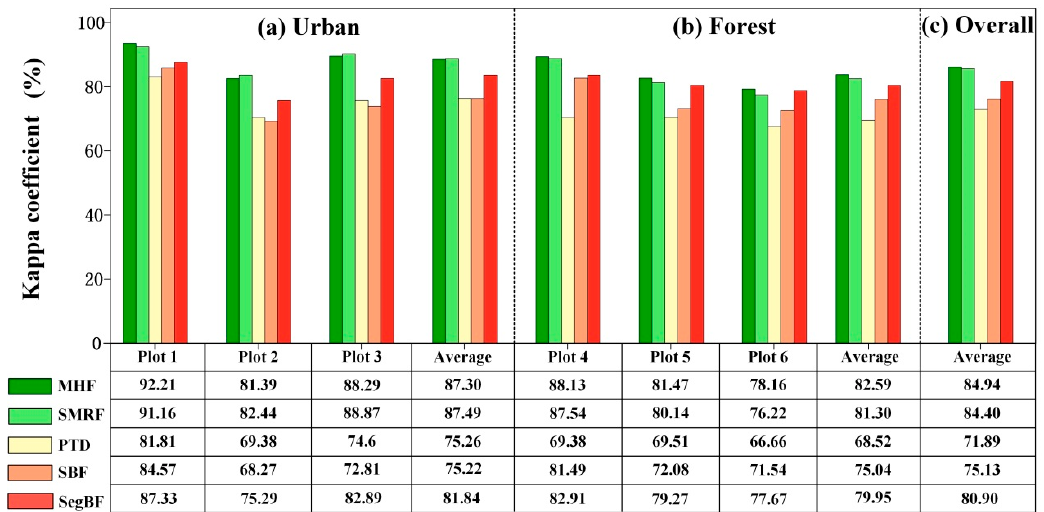
Figure 9. Kappa coefficients of all the filtering algorithms on the six plots including ( a ) urban, ( b ) forest and ( c ) overall areas.